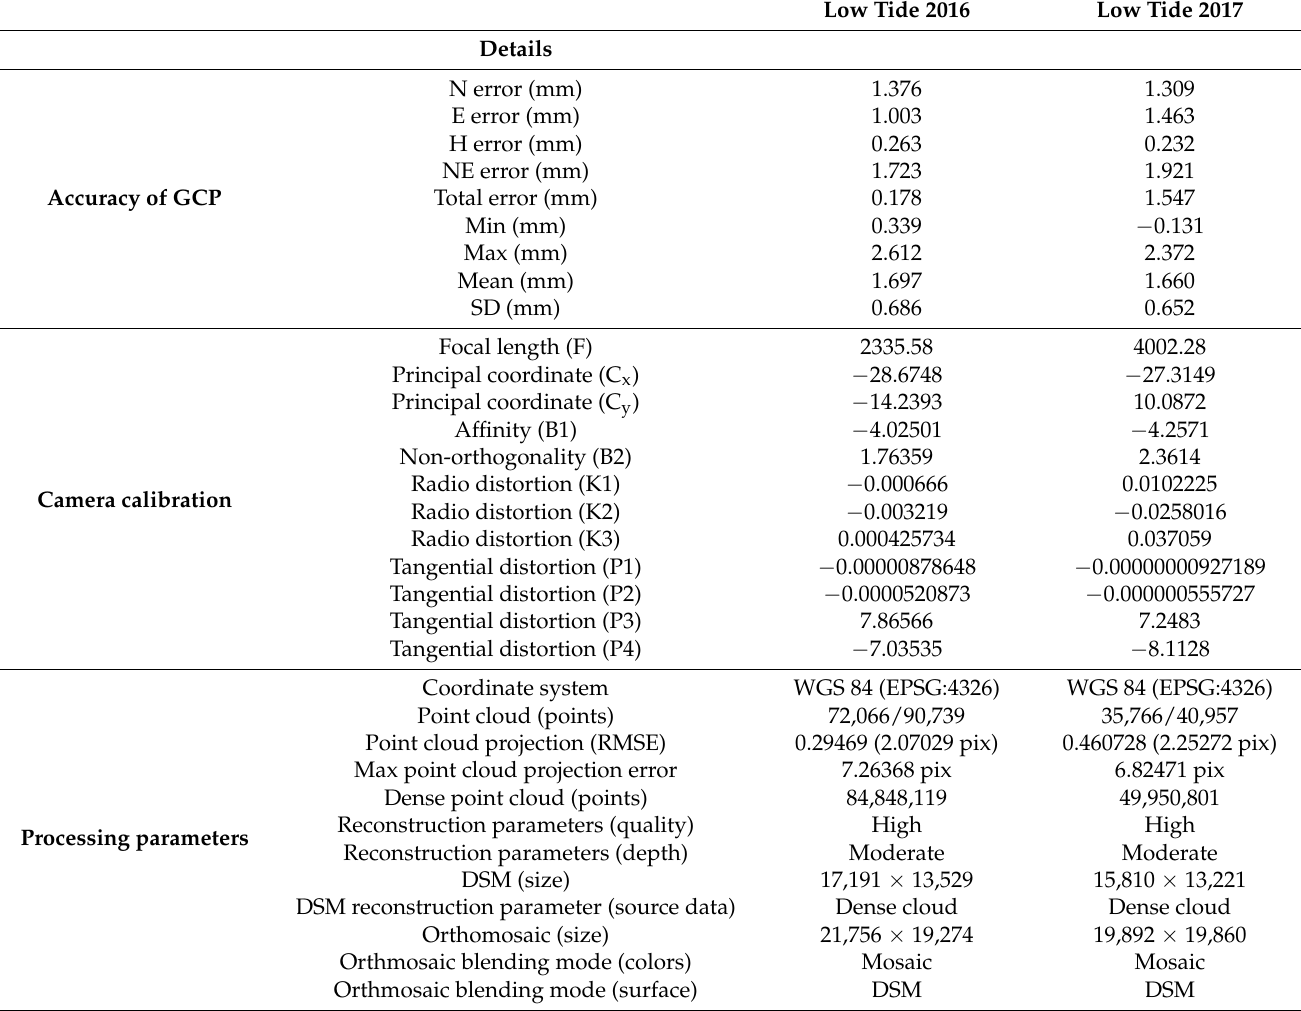
Table 1. The details of the UAV photogrammetric model comprise quality, accuracy, parameters, and processing results using the SfM-MVS